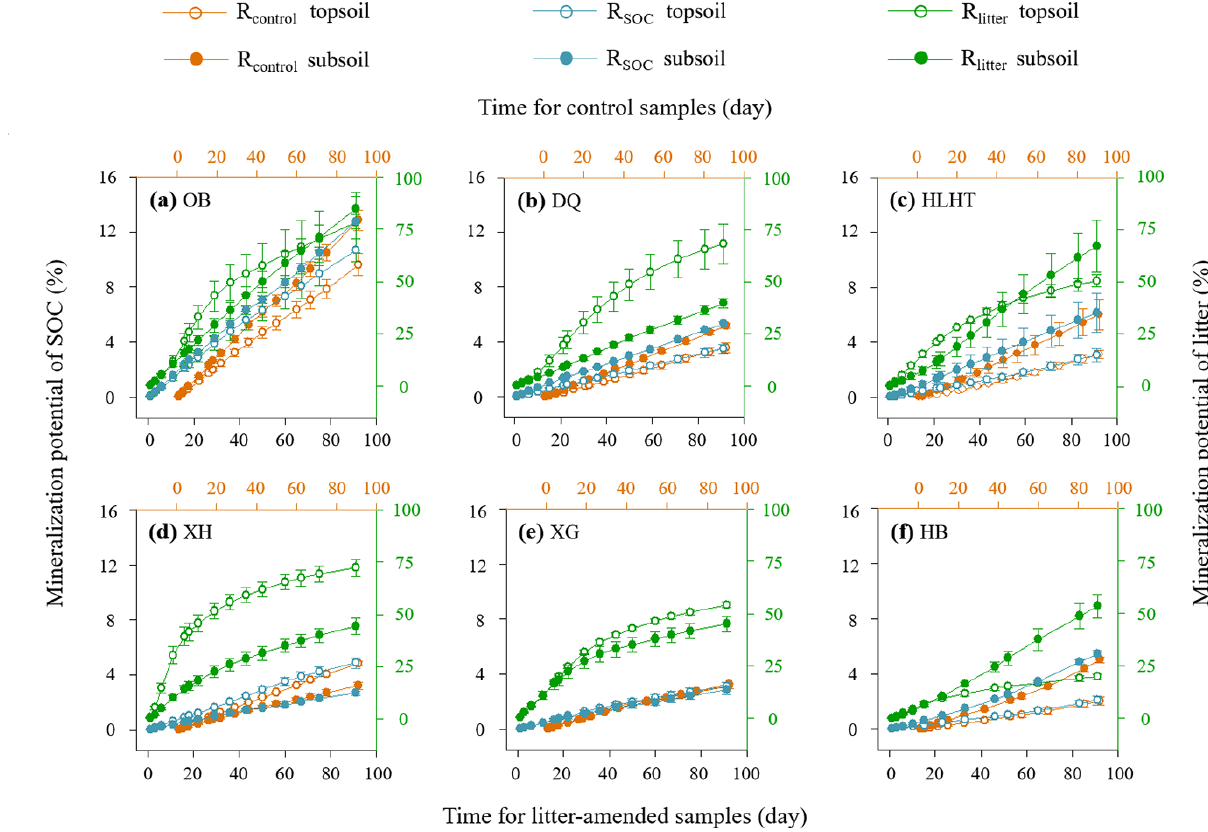
Figure 1. Mineralization potential of soil organic carbon (SOC) and leaf litter during the 91d incubation. R control and R SOC refer to the mineralization potential of SOC in the control and leaf-amended treatments, respectively, while R litter refers to the mineralization potential of leaf litter. Mean values are shown with standard error ( n = 3). The x axis (top) for R control is shifted to the right relative to the leaf-amended treatments (bottom axis) for better